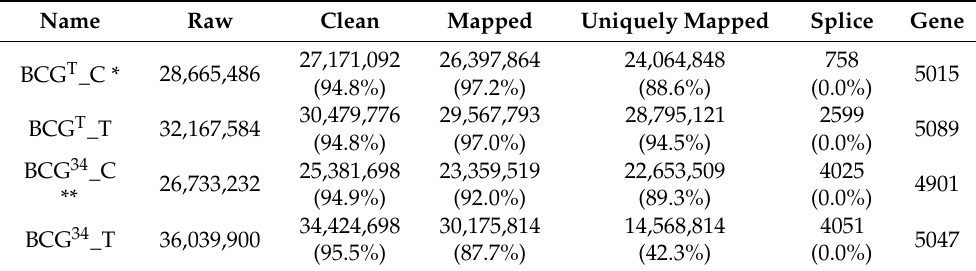
Table 2. Statistics of sequencing data